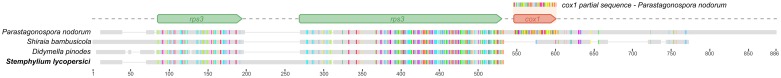
Schematic sequence alignment of RPS3 from Pleosporales species.It can be clearly seen conserved blocks of homology to RPS3 shared between the analyzed Pleosporales species. Regions of RPS3 that are conserved among Pleosporales are indicated with green boxes. The region homologous to COX1 particularly found in P. nodorum is indicated with a red box. The amino-acid sequences were aligned using MUSCLE with the default settings in Geneious 9.1.2. The detailed alignment is found in S3 Fig.